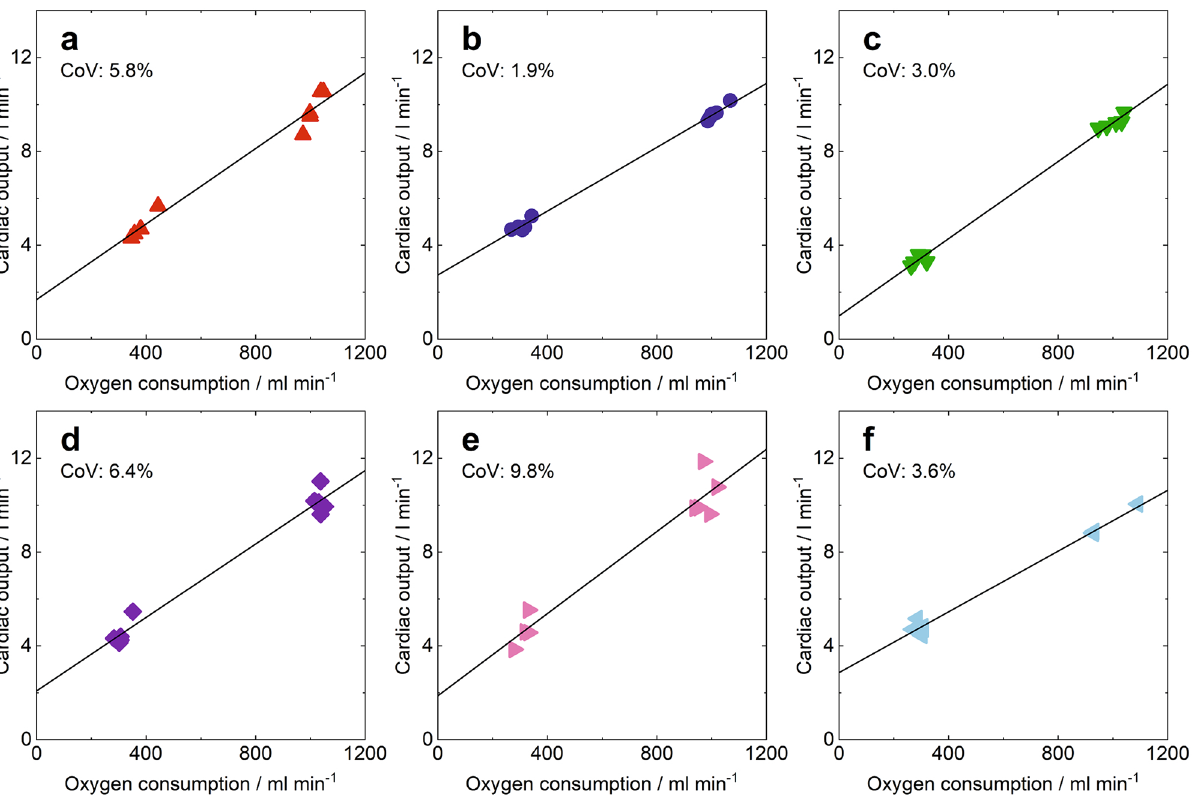
Figure 5. Intraparticipant relationships between cardiac output and oxygen consumption. ( a – f ), Cardiac output measurements are plotted against measured oxygen consumption for each participant in a separate panel, with intraparticipant linear fits shown with solid black lines. The quality of the fits is reflected in the coefficients of variation (CoV); below 10% of the mean cardiac output for every participant.